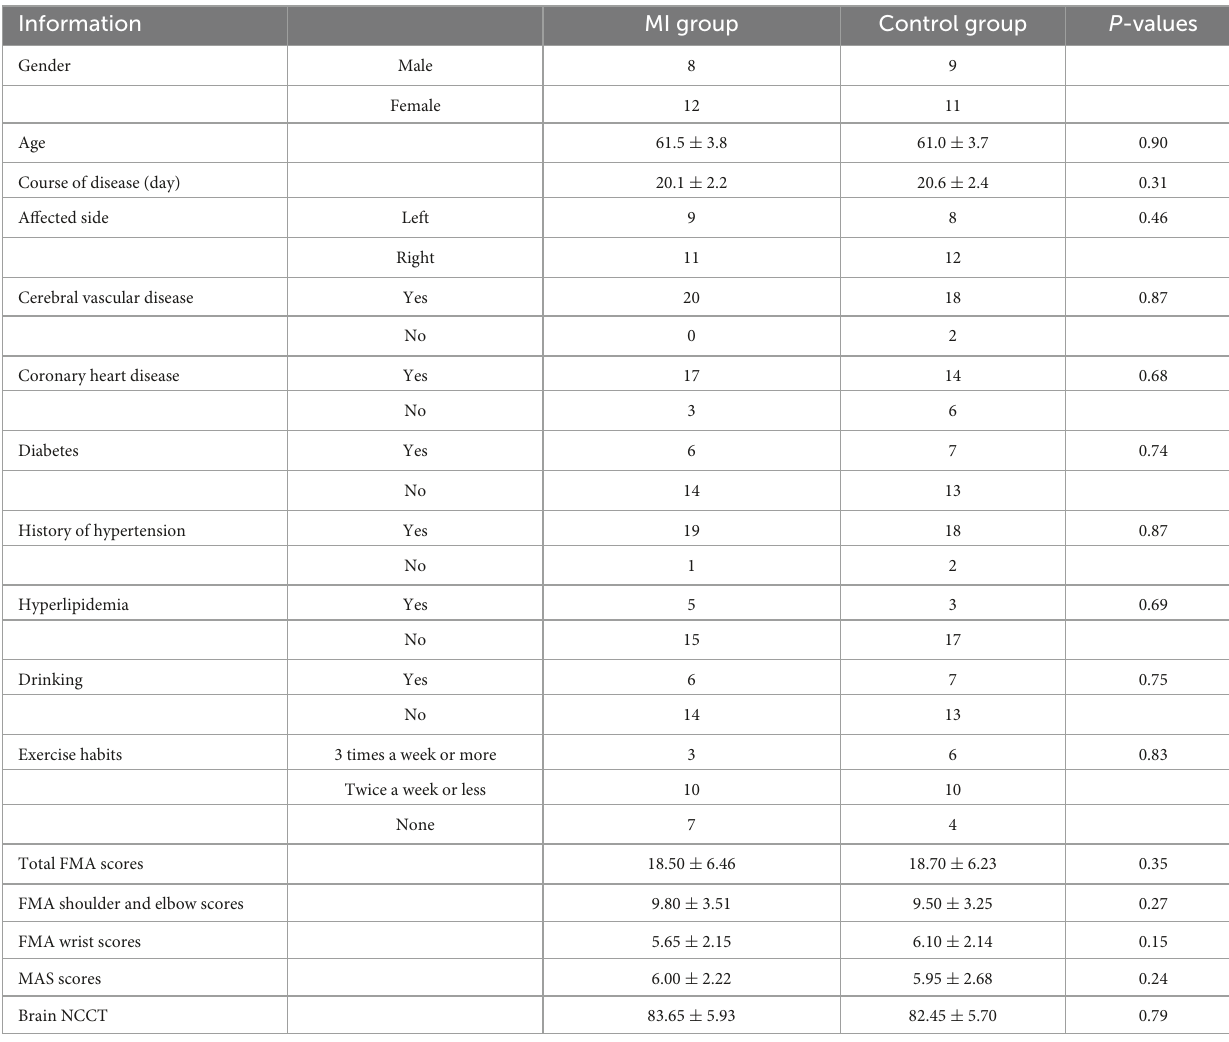
TABLE 1 Basic patient information.